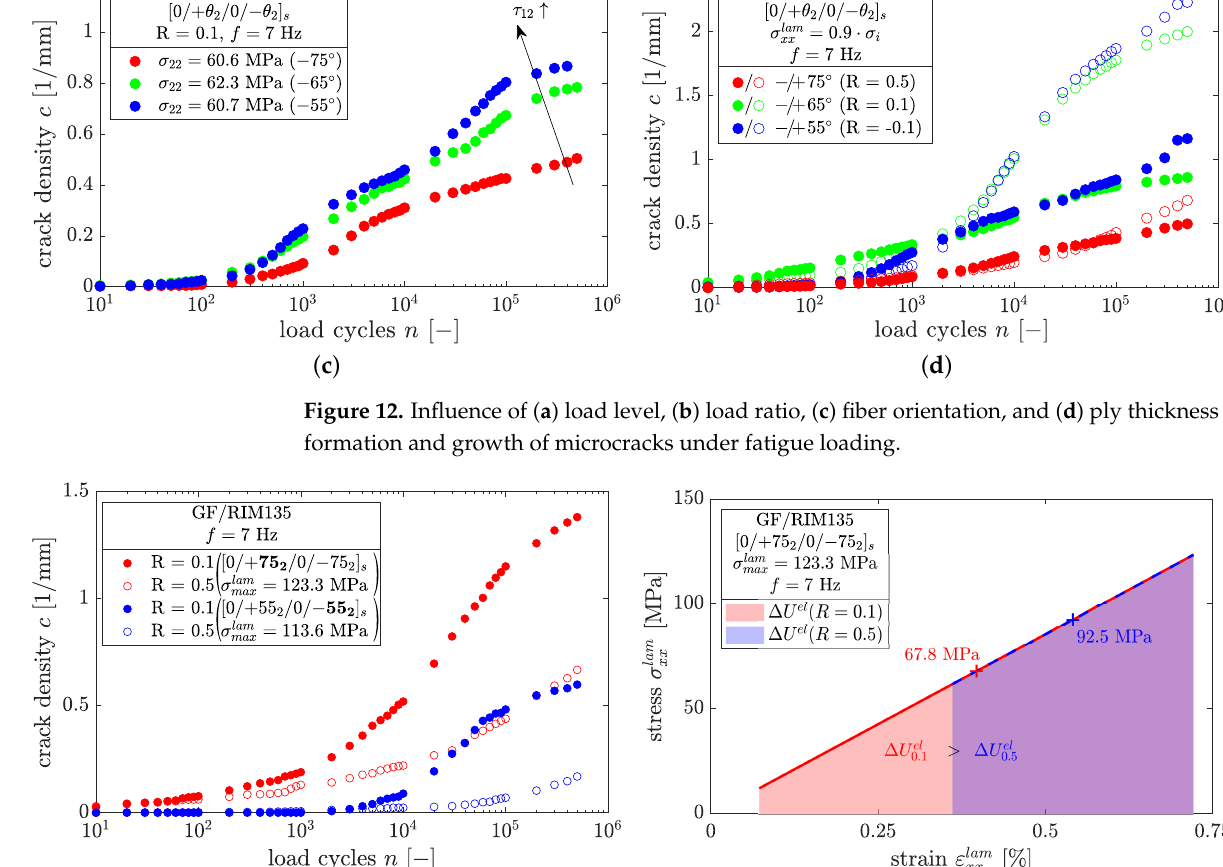
Figure 13. ( a ) Influence of mean stress on cyclic crack growth and ( b ) comparison of the range of the strain energy at different load